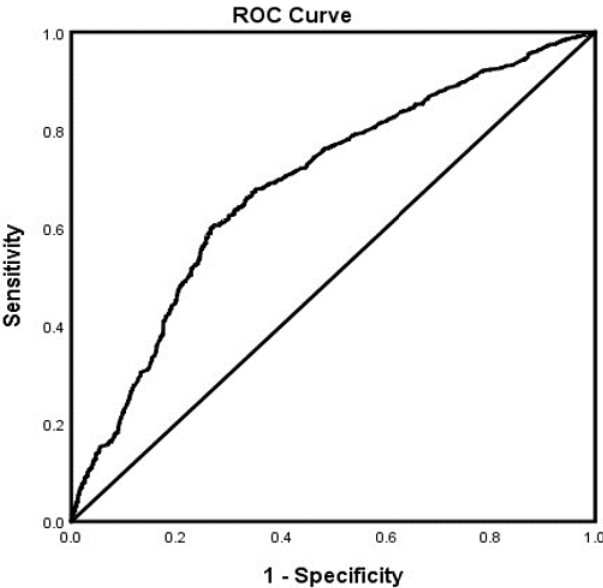
Figure 6. ROC curve associated with prediction of receiving cholinesterase inhibitor (ChEI) for women late onset Alzheimer’s disease patients. Higher area under the curve (AUC) values in ROC analysis indicate better discrimination of the score for the measured outcome. Classification table (overall correctly classified percentage = 66.6%) and area under the ROC curve (AUC = 0.688, 0.674–0.702) were applied to check model fitness.